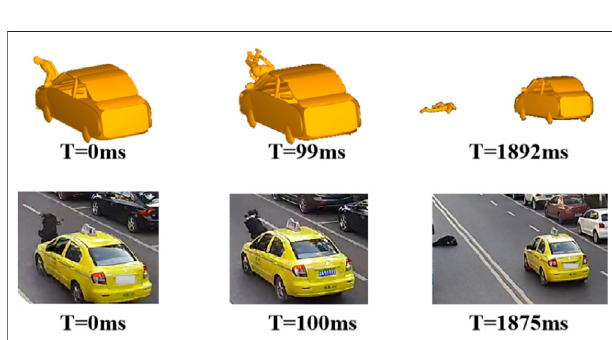
FIGURE 3 | Comparison of pedestrian kinematics between reconstruction and video